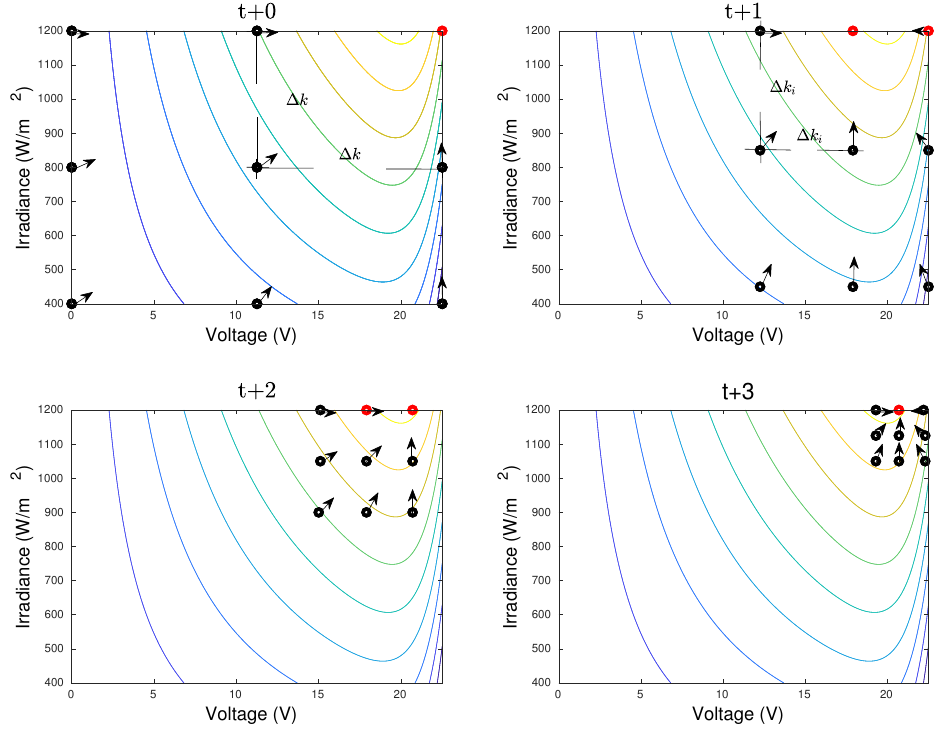
Figure 8. IPSM (improved pattern search method)